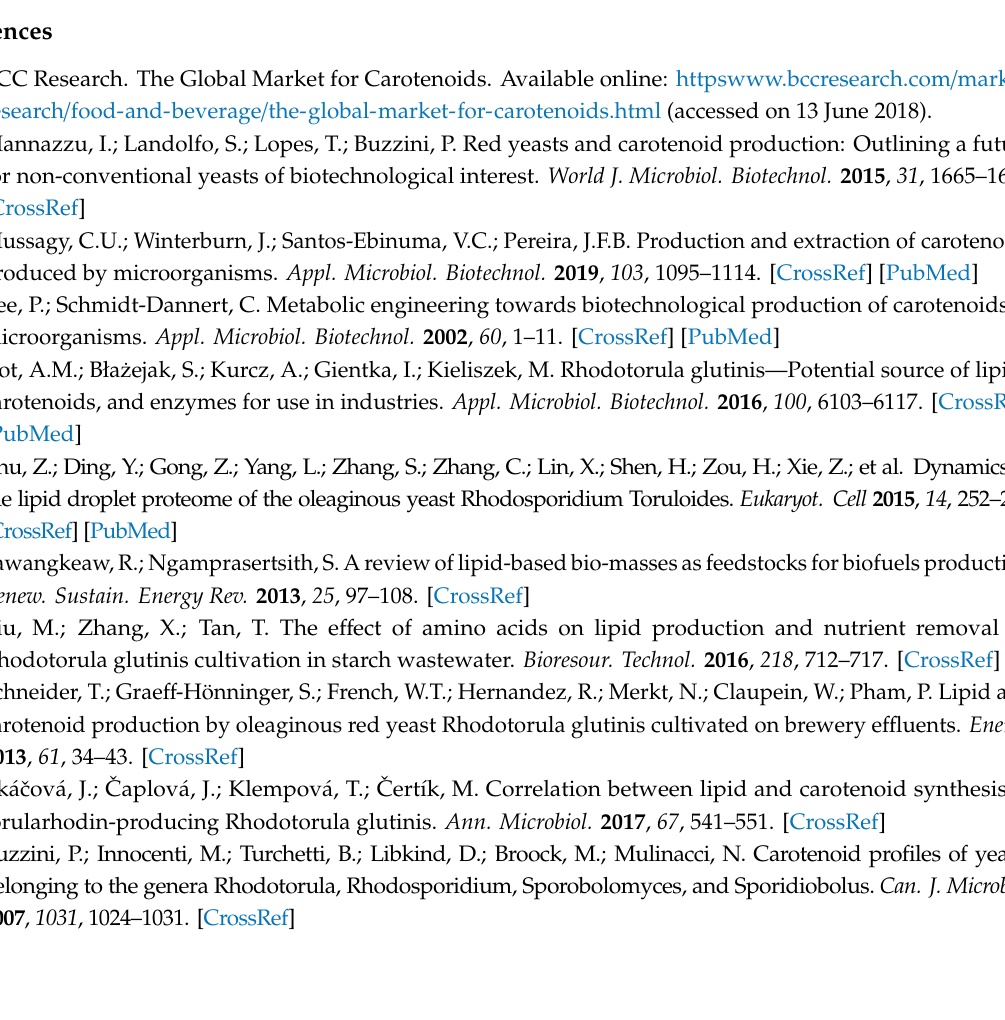
Figure S1: The multivariate tests (SPSS) was used to detect the statistically significant di ff erences between C / N ratio and di ff erent nitrogen sources treatments on DCW, TL, and TP after three and sixth